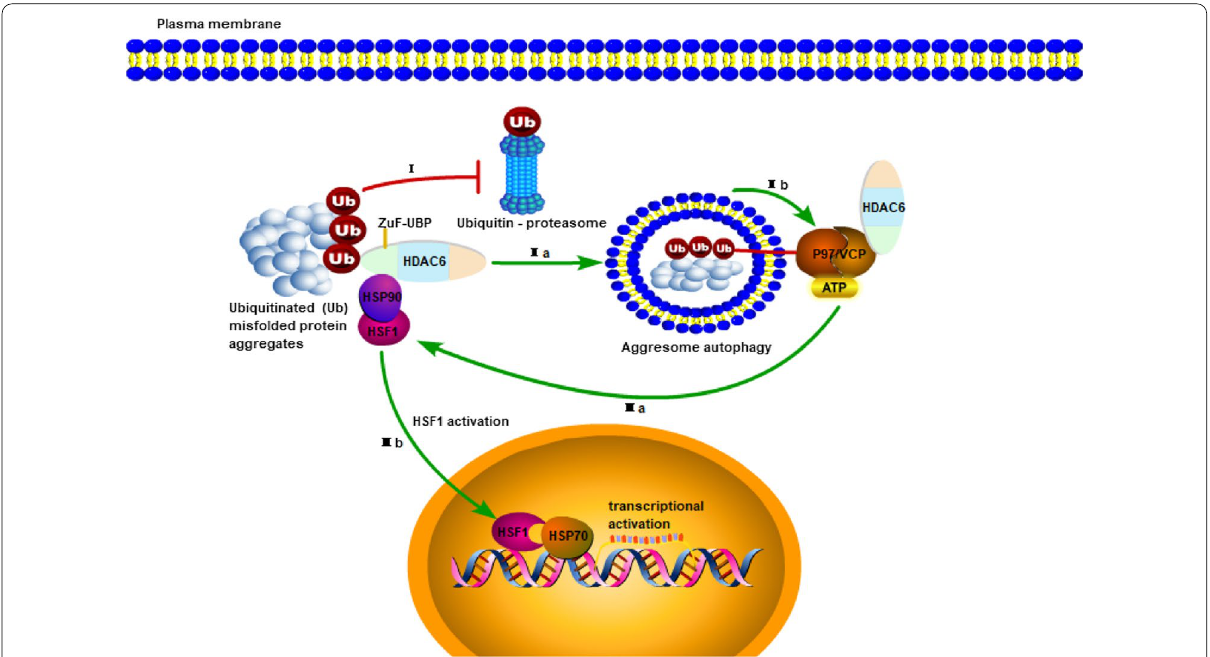
Fig. 3 Regulation Hsp90 by the ZnF-UBP of